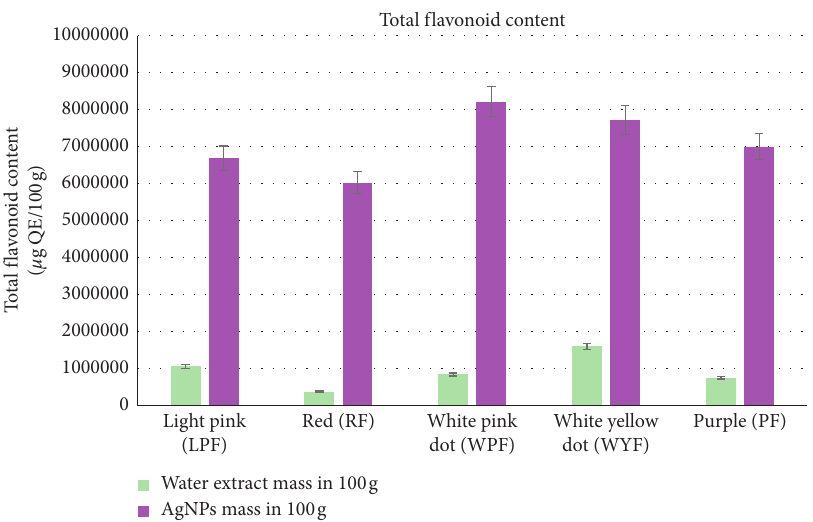
Figure 11: Total flavonoid content of water extracts and AgNPs expressed as quercetin equivalents (QE).